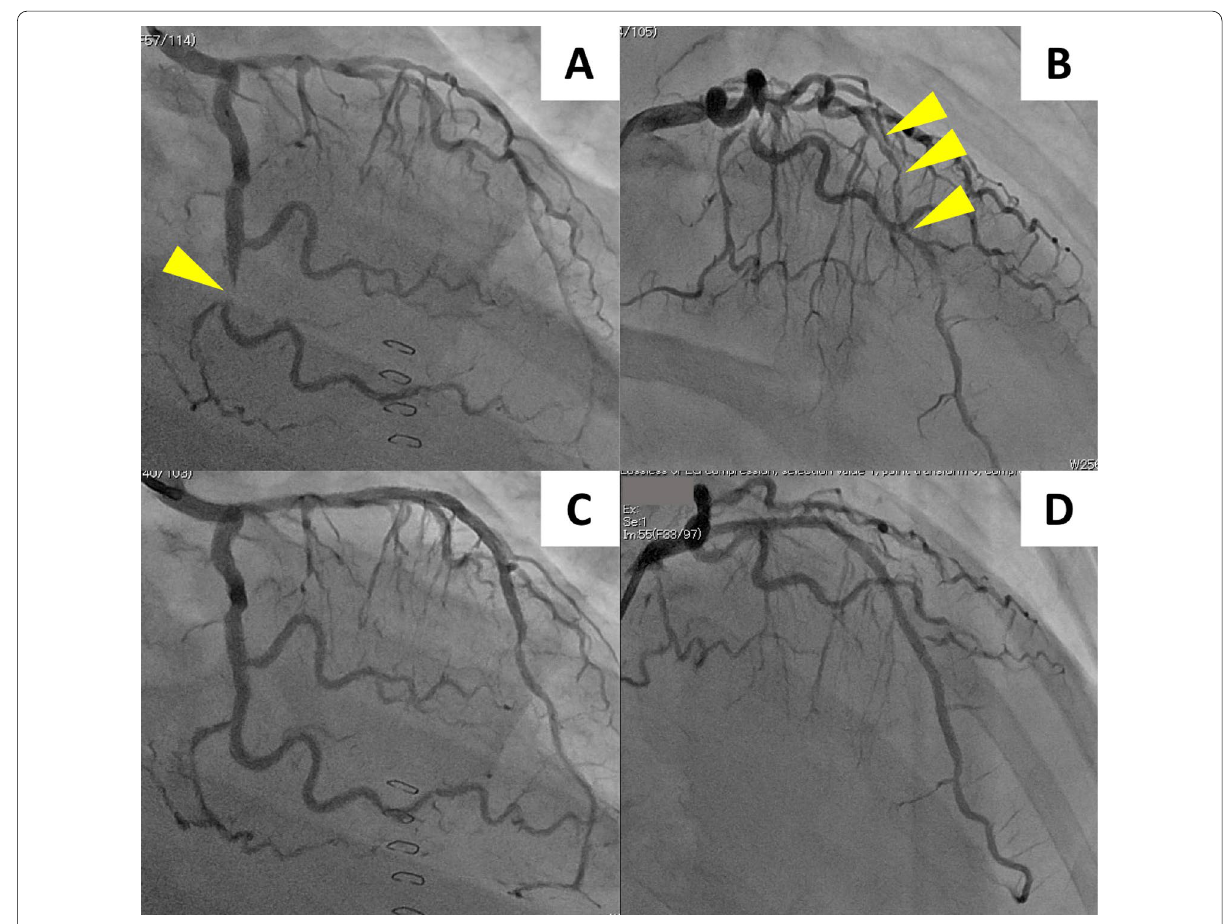
Fig. 3 Coronary angiography. A Stenosis of the left anterior descending artery (yellow arrow). B Stenosis of the left circumflex artery (yellow arrows). C Successful stent placement in the left anterior descending artery. D Successful stent placement in the left circumflex